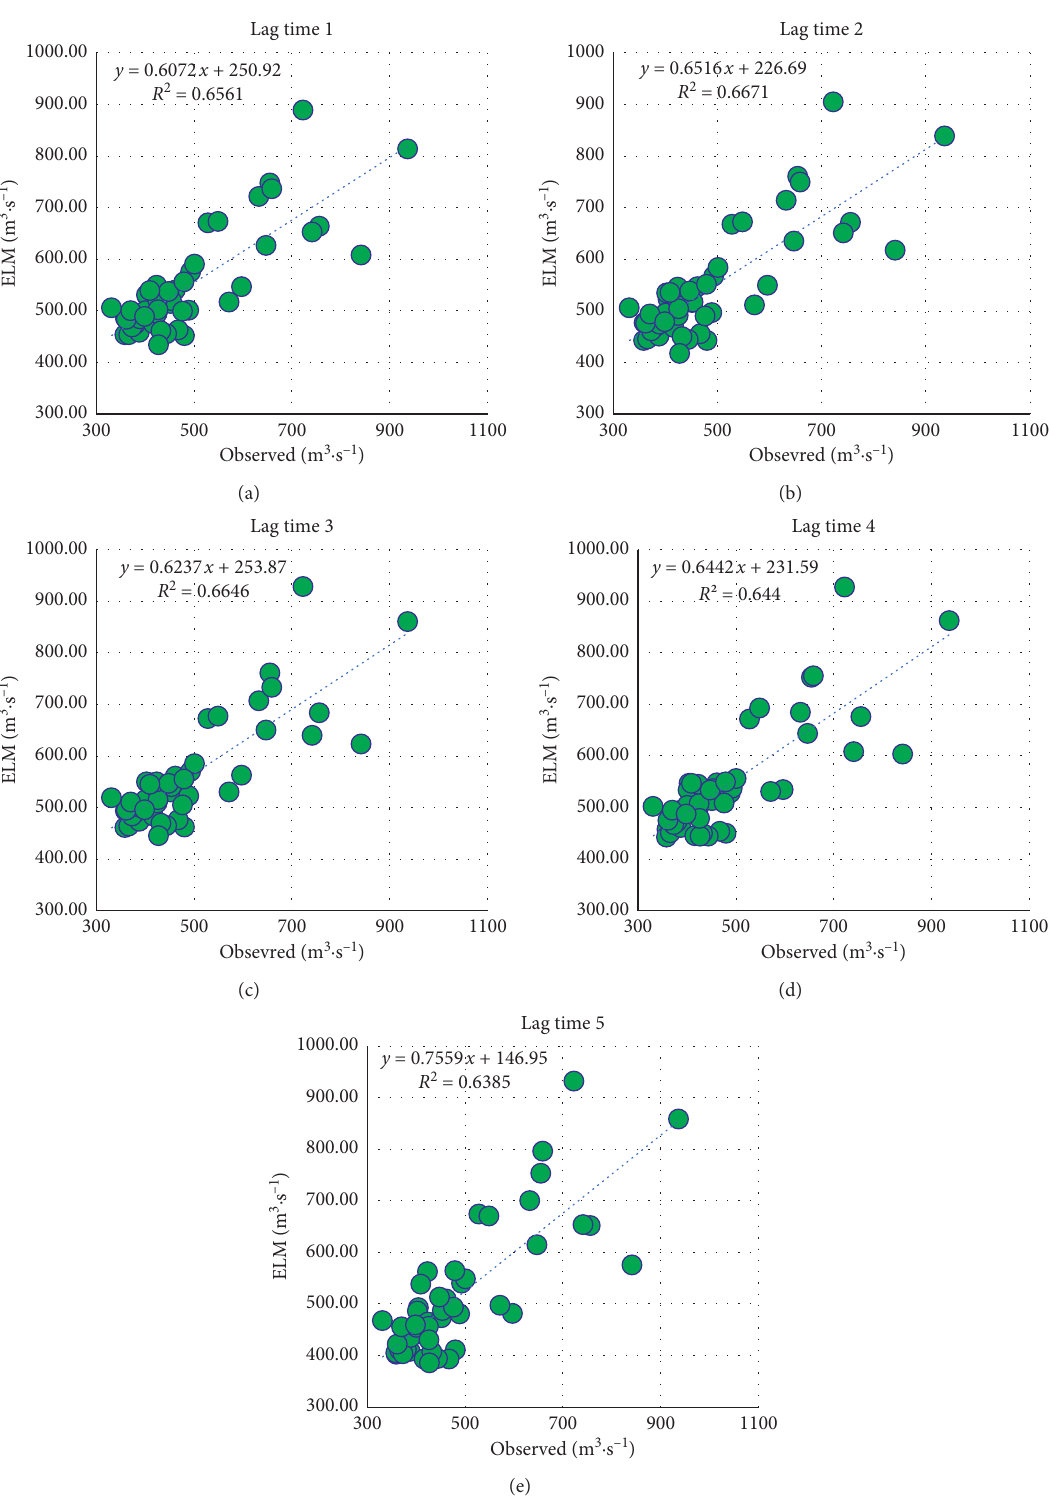
Figure 11: Scatter plot variation between the observed and forecasted river flow using the ELM model and for the five input